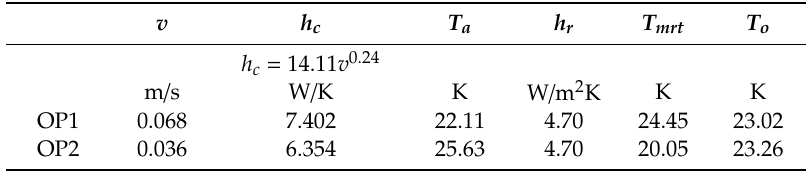
Table 1. Calculation of indoor air temperature T a , mean radiant temperature T mrt , and operating temperatures T o in summer for both options.